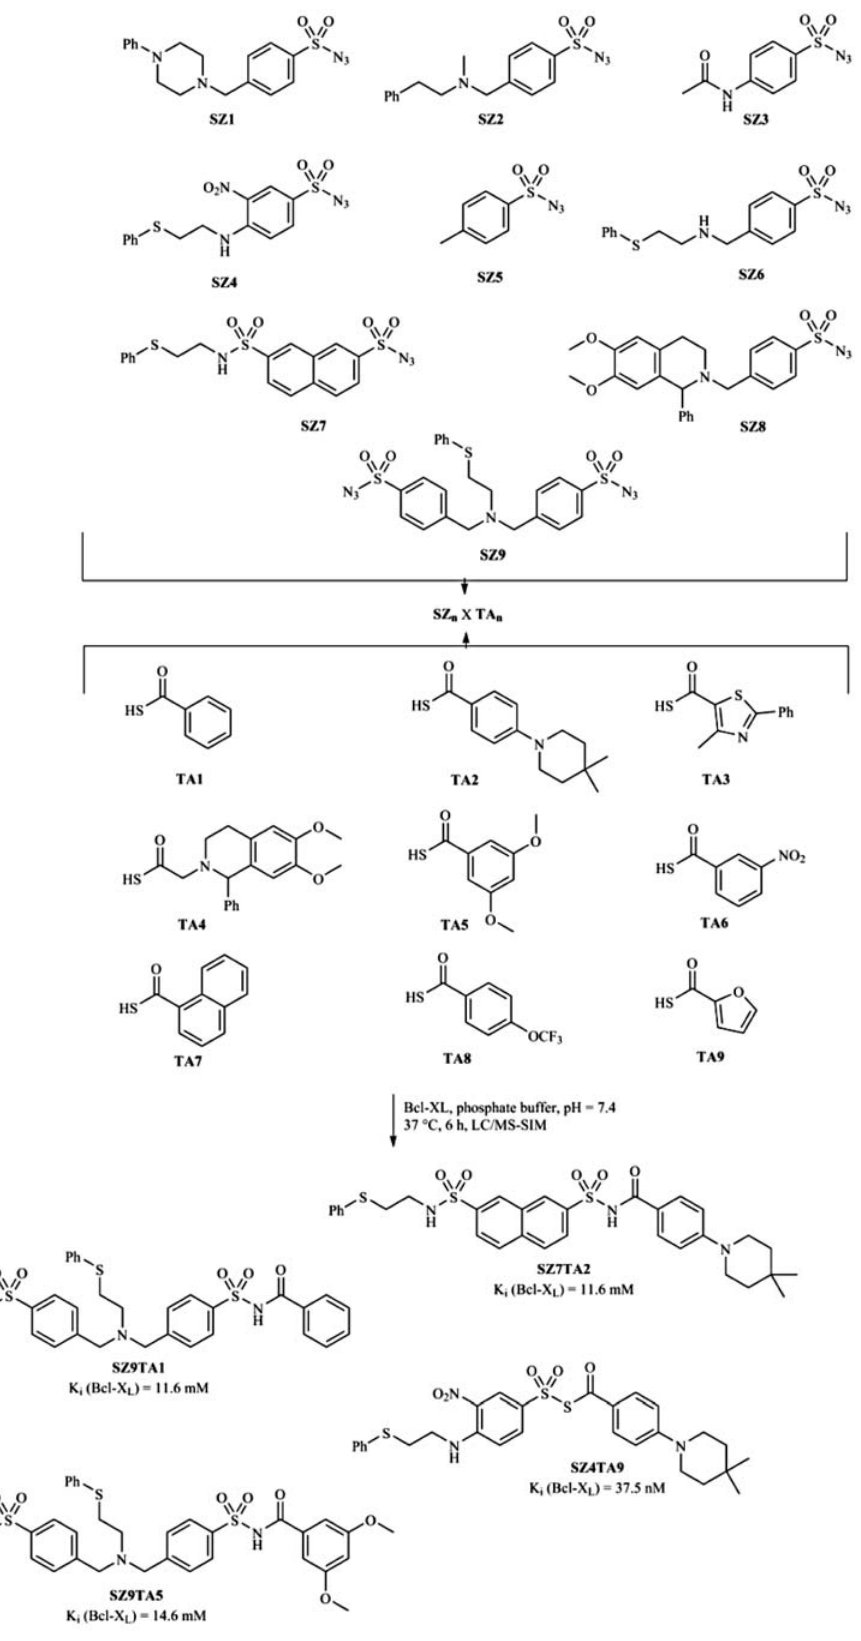
Figure 10. Screening of anti-apoptotic Bcl-X